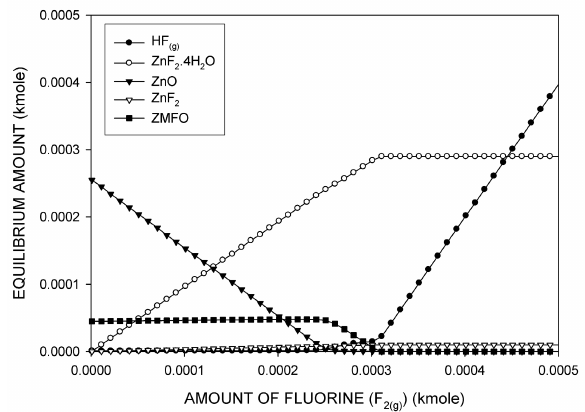
Figure 7(c). Effect of the amount of zinc on the equilib- rium amounts of the zinc-containing species in the Zn-Fe- Mn-O-H-C-F system at room